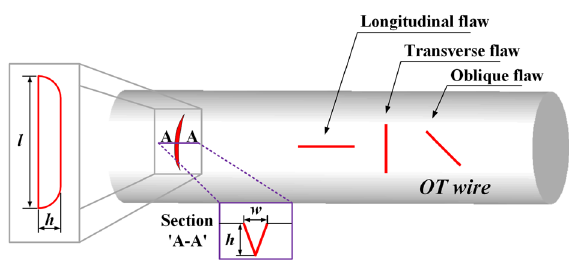
Figure 8. Schematic illustration and direction of surface flaws on the OT